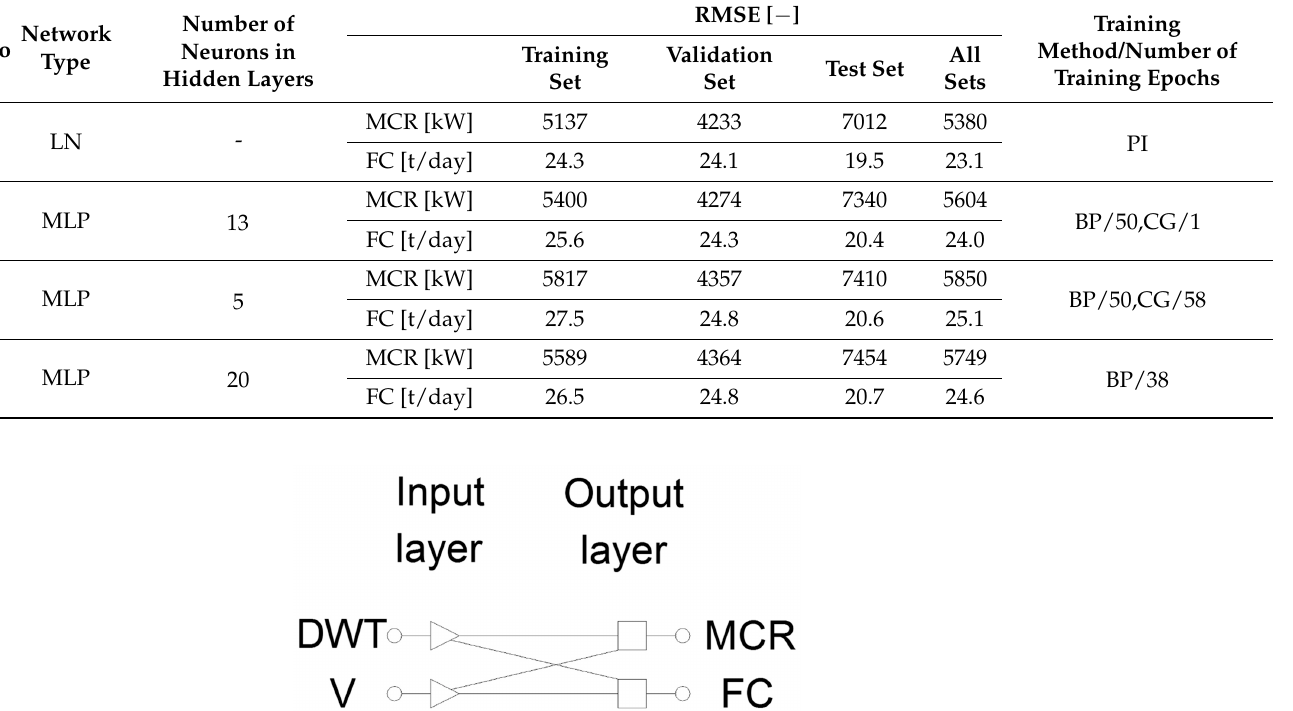
Table 6. An overview of the neural networks that were developed to estimate the engine power and fuel consumption of container ships, where: BP—error back propagation algorithm, CG—conjugate gradient algorithm, PI—pseudo-inverse algorithm and RMSE—root mean square error.